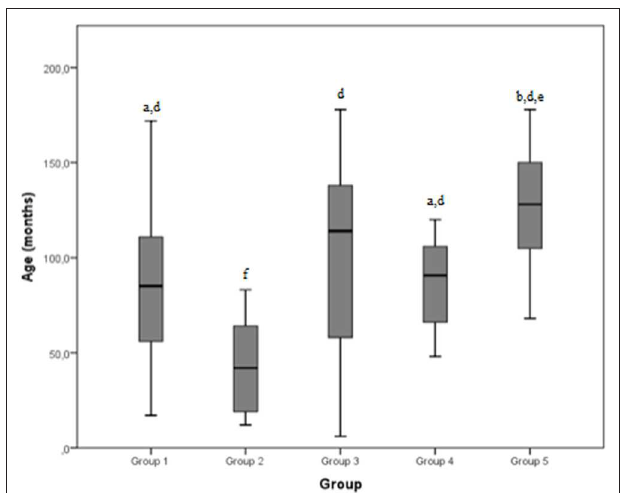
FIGURE 2 | Age (months) differences between the five examined groups. Statistically significant differences are indicated as follows: (a) significantly different from group 5; (b) significantly different from group 4; (d) significantly different from group 2; (e) significantly different from group 1; (f) significantly different from all other groups.